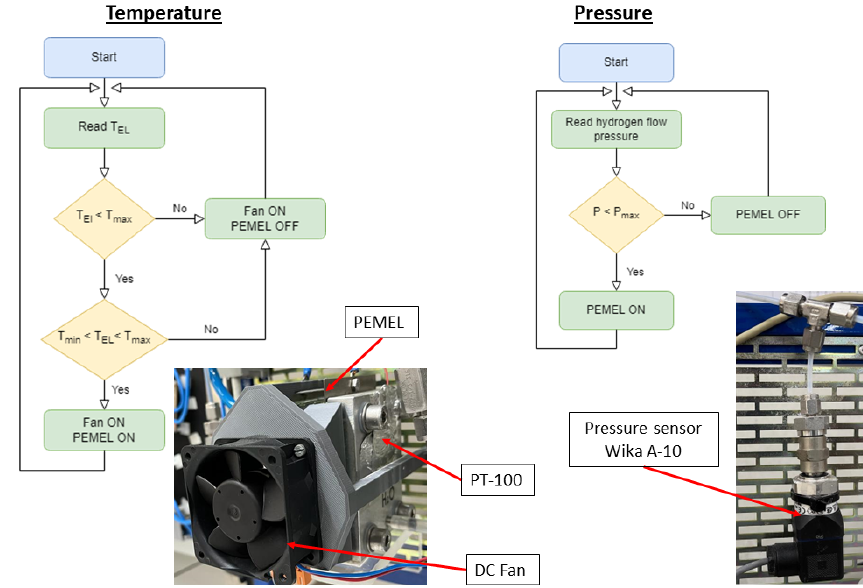
Figure 3. Control algorithms for temperature and pressure and equipment involved.